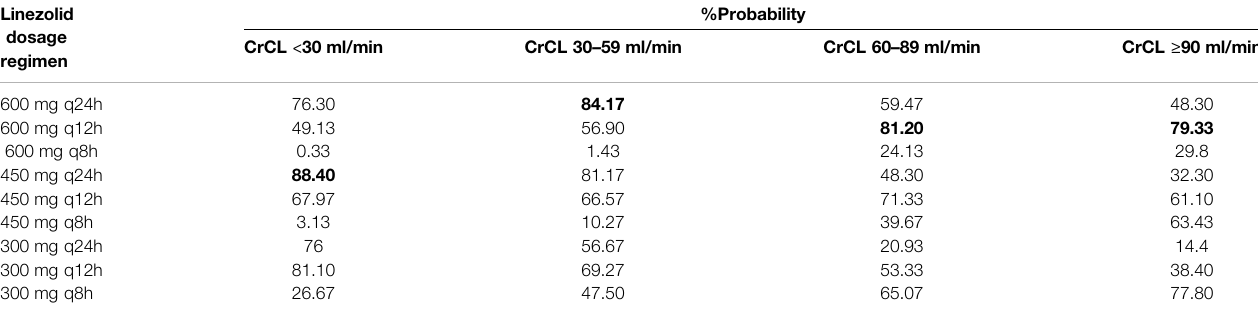
TABLE 3 | Simulated probability of attaining linezolid trough concentrations associated with ef fi cacy and toxicity strati fi ed by renal function. Linezolid dosage regimen